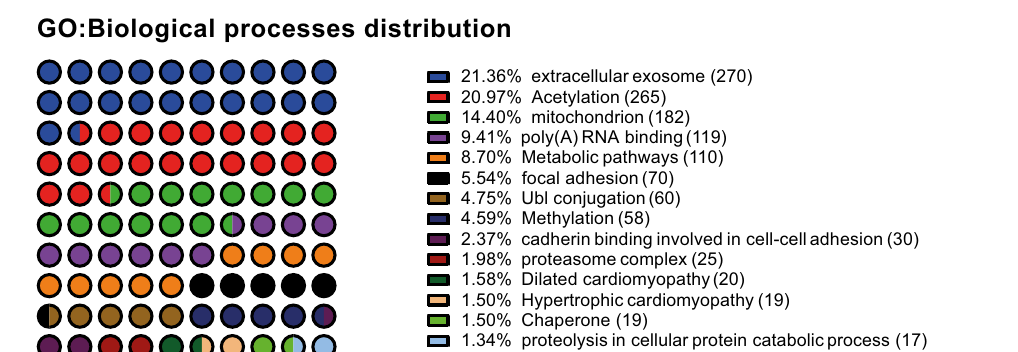
Fig. 2 Increased cardiac EV cargo secretion in β -cat Δ ex3 hearts. a Nanoparticle tracking analyses (NTA) con fi rmed isolation of extracellular vesicles with a mean size of 160.0 ± 69 nm. Visualization of the puri fi ed vesicles by hydrophilic fl uorescence analog of cholesterol (Chol-PEG-KK114) staining. b Electron microscopy con fi rmed the isolation of round and cup-shaped particles, typical for exosomal vesicles less than 200 nm in size. c Western blot showing expression of the exosome marker CD81 in the higher speed-centrifugation fraction (P100) from mouse hearts and the absence of Golgi-marker GM130 and endoplasmic reticulum marker Calnexin, which were present in the cell pellets and lower-speed centrifugation (S100). d Western blot showing increased exosomal marker TSG101 in EV isolated from β -cat Δ ex3 hearts versus control, as well as showing absence of Calnexin, GAPDH and Vinculin expression in both conditions upon equally amount of loaded proteins as visualized by the stain free gel image. e GO biological processes distribution of enrichment analysis of total proteomic data (573 proteins) obtained from isolated vesicles of β -cat Δ ex3 hearts and control con fi rming an association of vesicle contained proteins with “ extracellular exosomes ” ( n = 2 (each a pool of 2-3 hearts) biological replicates and technical triplicates for NTA and MS analysis, n = 4, biological replicates (for Western blots). GO enrichment represents – log10 p -value ( p -value <0.05) and term fusion was β -cat Δ ex3 hearts puri fi ed EVs were signi fi cantly enriched for all PKACA and BAG2 (shown in Fig. 3B). This went in line with the stress response of the β -cat Δ ex3 hearts and elevated Ub-proteins seven α and seven β chains of the 20S proteasome components, while components of the 19S proteasome core were not enriched. linked to pathologic remodeling. Next, we analyzed the levels of We also observed enrichment of molecular chaperones, co- Ub-proteins in isolated EVs and similar to the fi nding in the chaperones and PQC associated proteins previously described in whole heart lysate, we observed increased levels of ubiquitinated secreted exosomes 28 such as HSPA70, HSP90AB1, VCP, UBE2N, proteins in EVs from β -cat Δ ex3 hearts (Fig. 4A). Furthermore, the